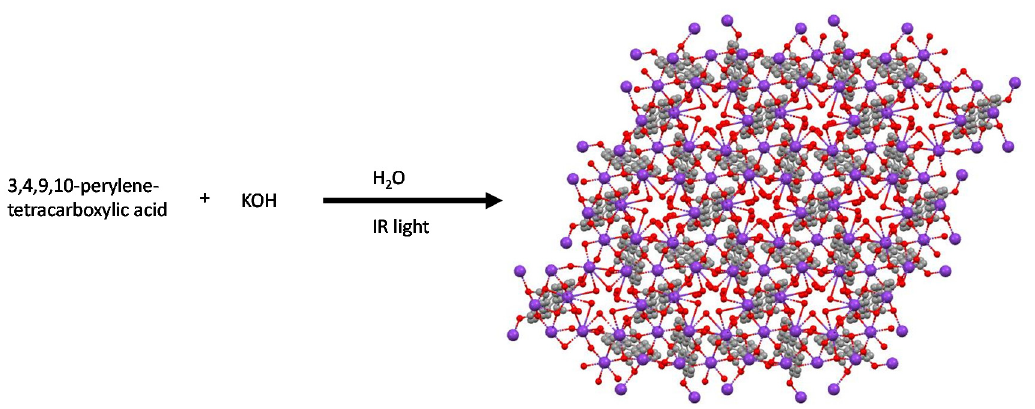
Figure A3. Synthetic scheme with the structure of the MOF.